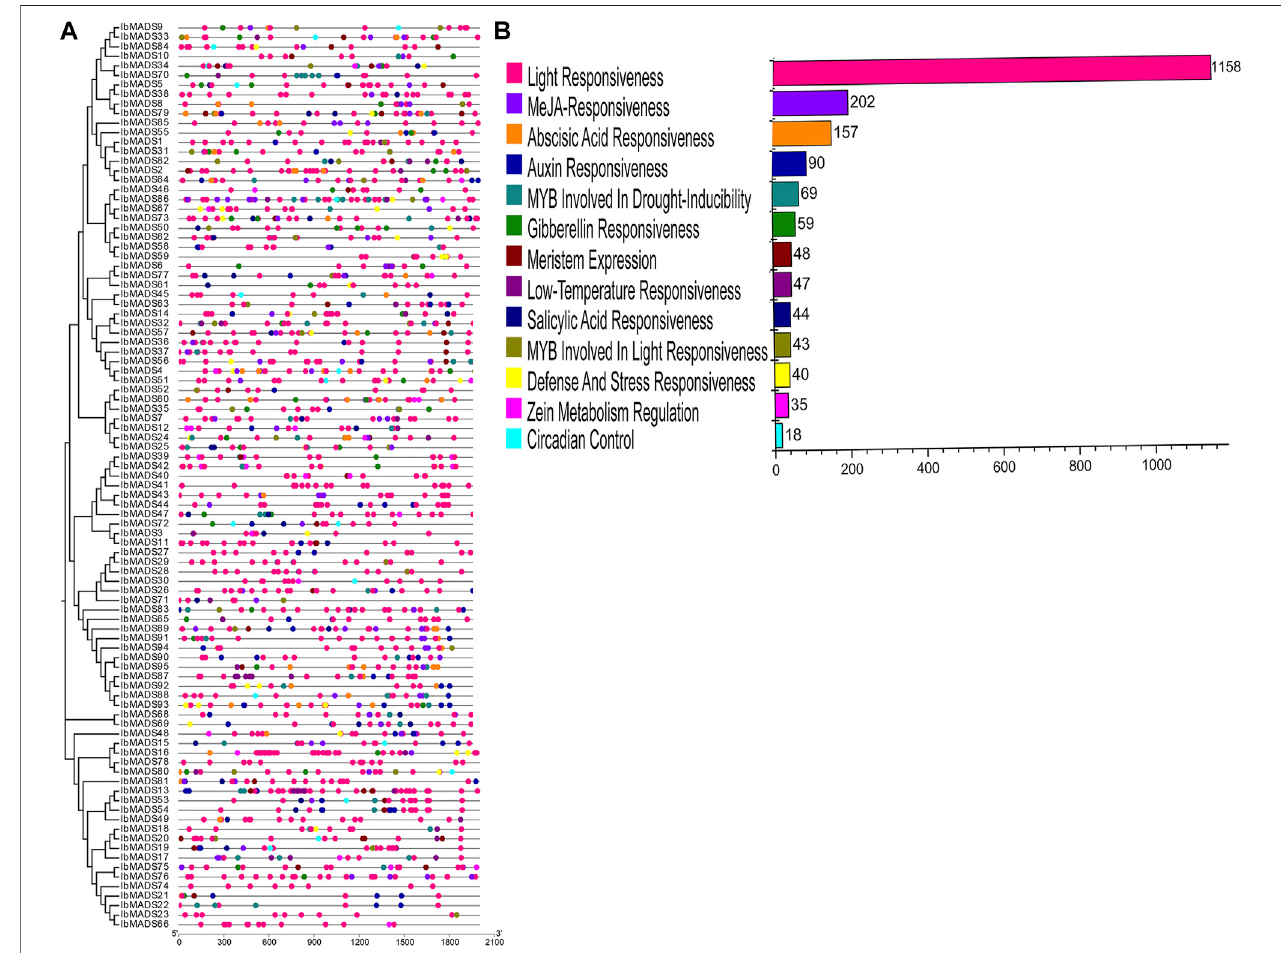
FIGURE 5 | Cis -acting elements analysis of sweet potato MADS-box. (A) Cis -acting element distribution. (B) Cis -acting element numbers.